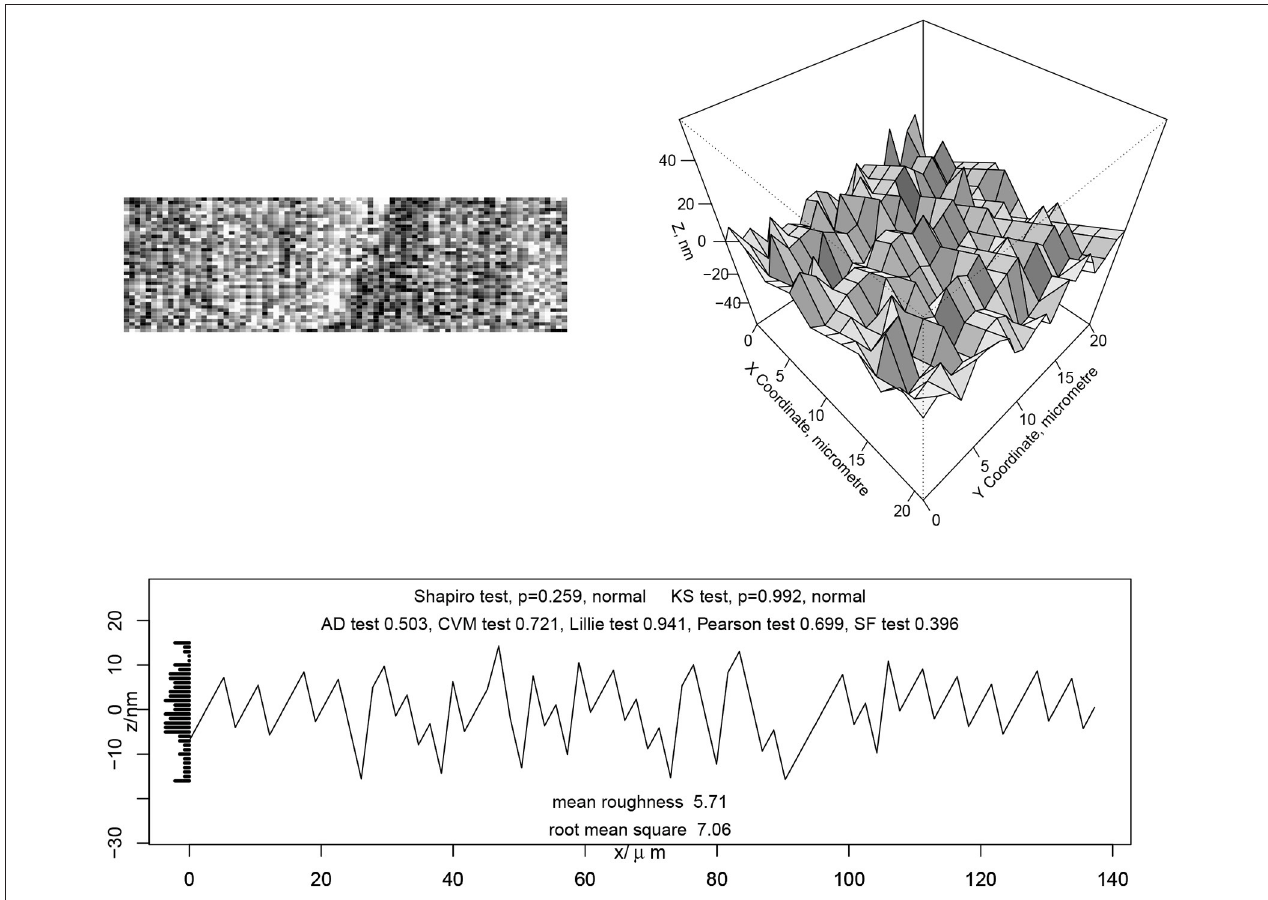
FIGURE 3 | The profilometer scan of the a-C (bias) sample. (Left) full measured patch 40 x 120 µ m . (Right) extracted small region 20 x 20 µ m . (Bottom) A typical profile with normality tests and two descriptive statistics (values are in nm): the root mean square (rms) and the mean